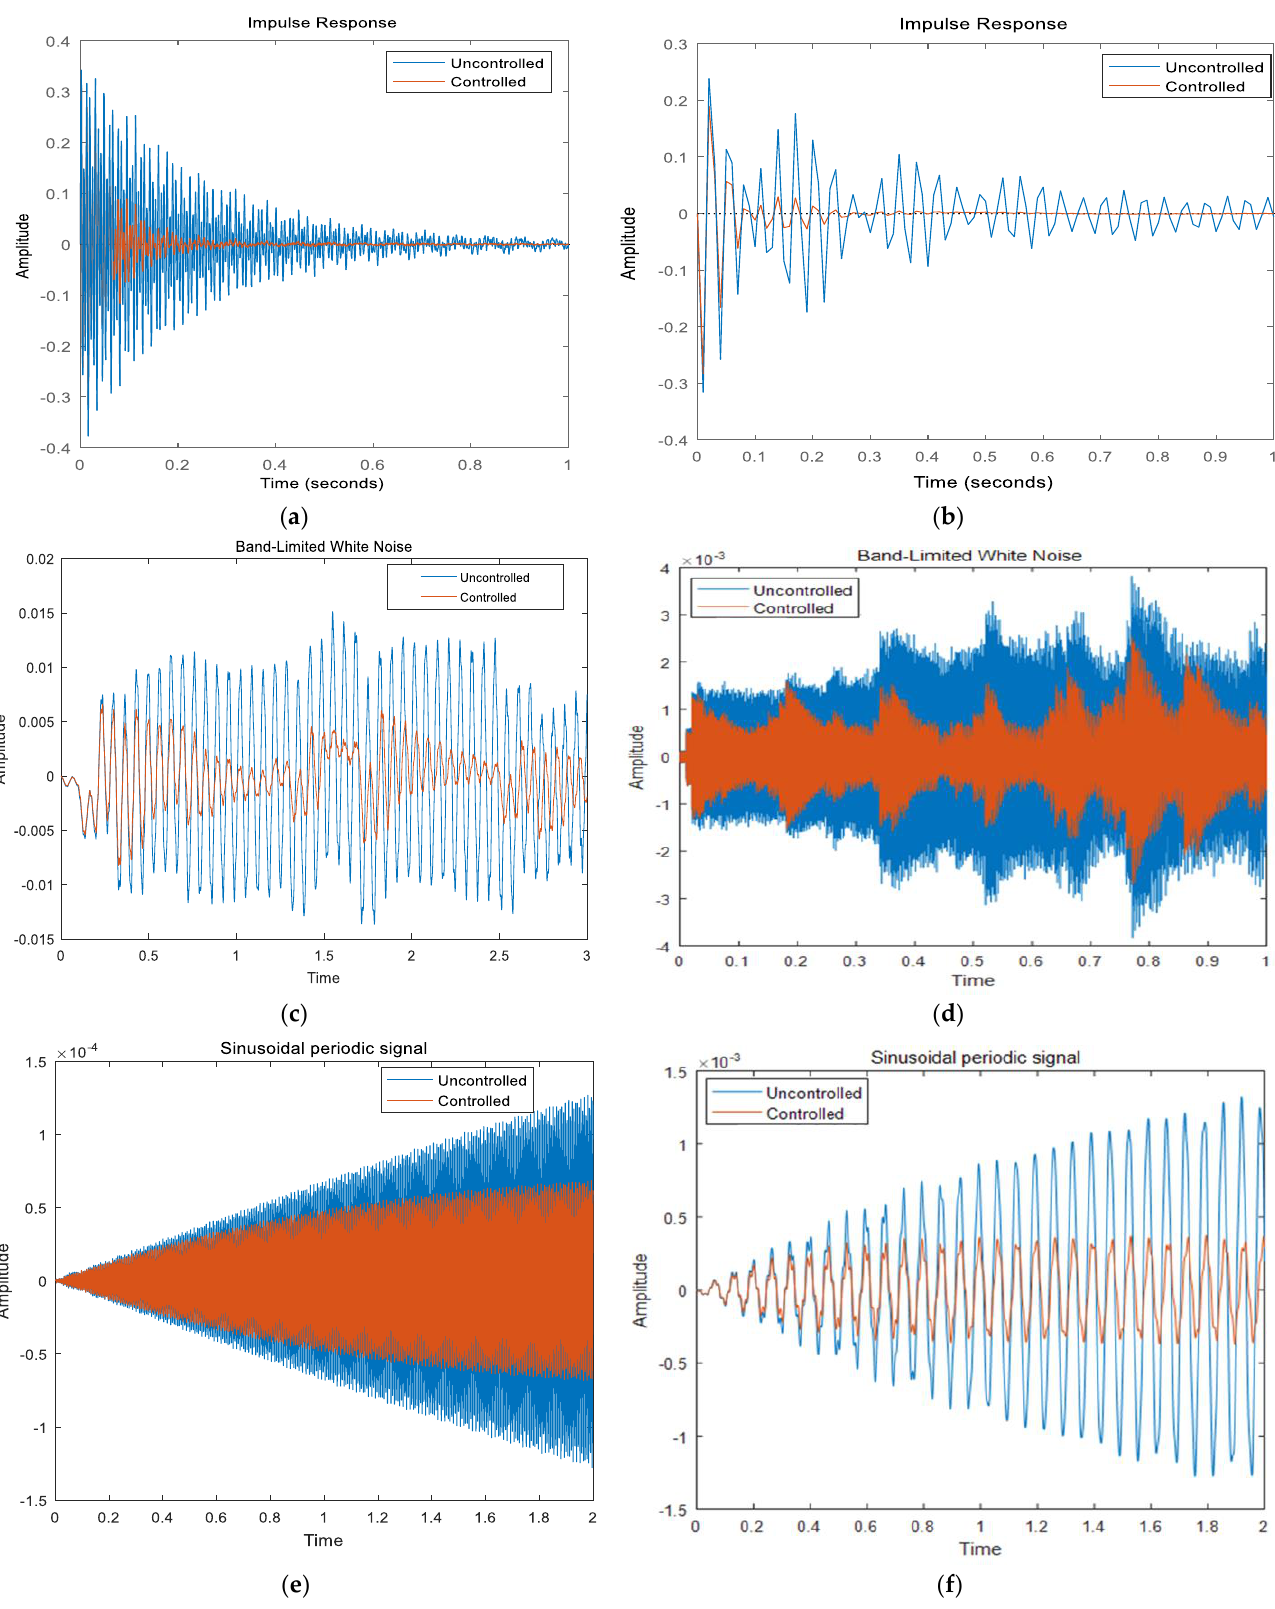
Figure 8. System control before and after response diagram. ( a ) CFFF Plate Response under Pulse Excitation; ( b ) CFCF Plate Response under Pulse Excitation; ( c ) CFFF plate response under band-limited white noise; ( d ) CFCF plate response under band-limited white noise; ( e ) CFFF plate response under sinusoidal period signal; ( f ) CFCF plate response under sinusoidal period signal.